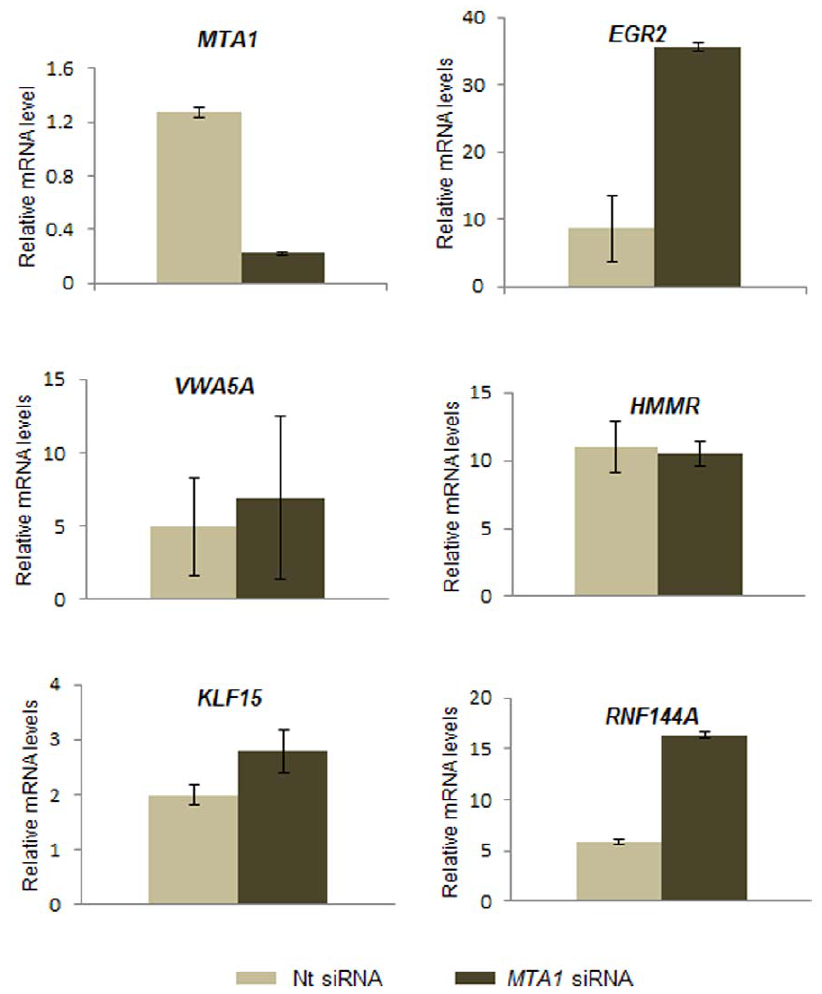
Figure 8. RT-qPCR was performed using the RNA obtained from the wild type MCF-7 cells and MCF-7 cells transfected with the MTA1 -siRNA. The differential regulation of the selected genes ( EGR2 , HMMR , KLF15 , RNF144A , and VWA5A ) was observed in agreement with the Microarray and the RT-QPCR in the MEFs.